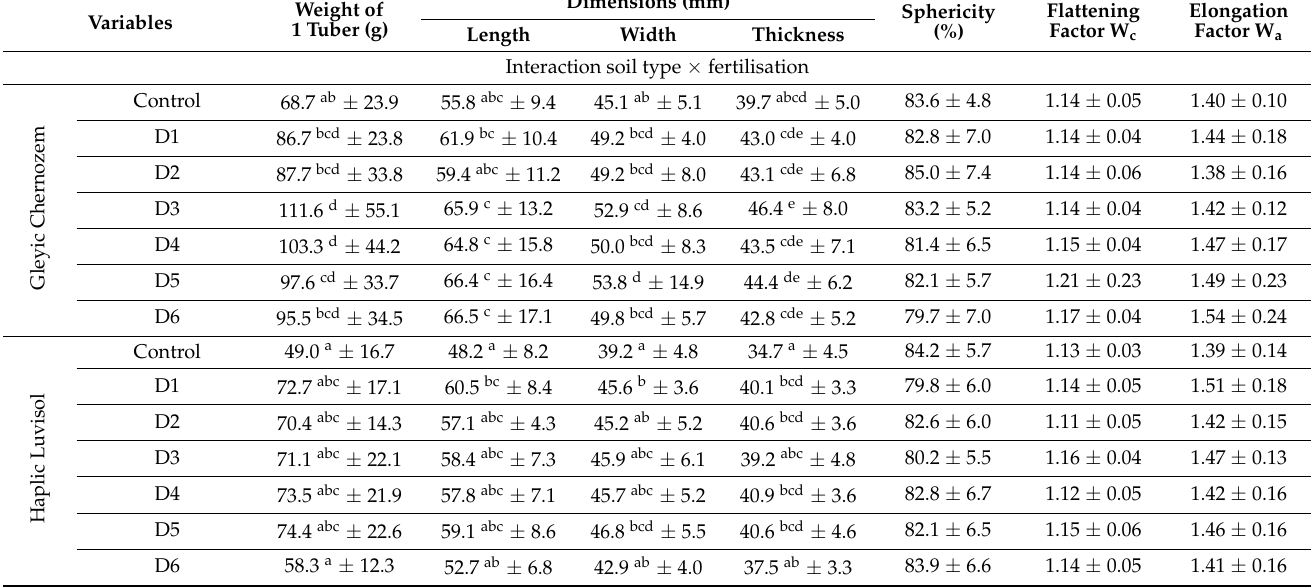
Table 3. Morphological features of the potato tubers examined depending on soil type, fertiliser treatment and year of research—mean for factors and interaction soil type x fertiliser